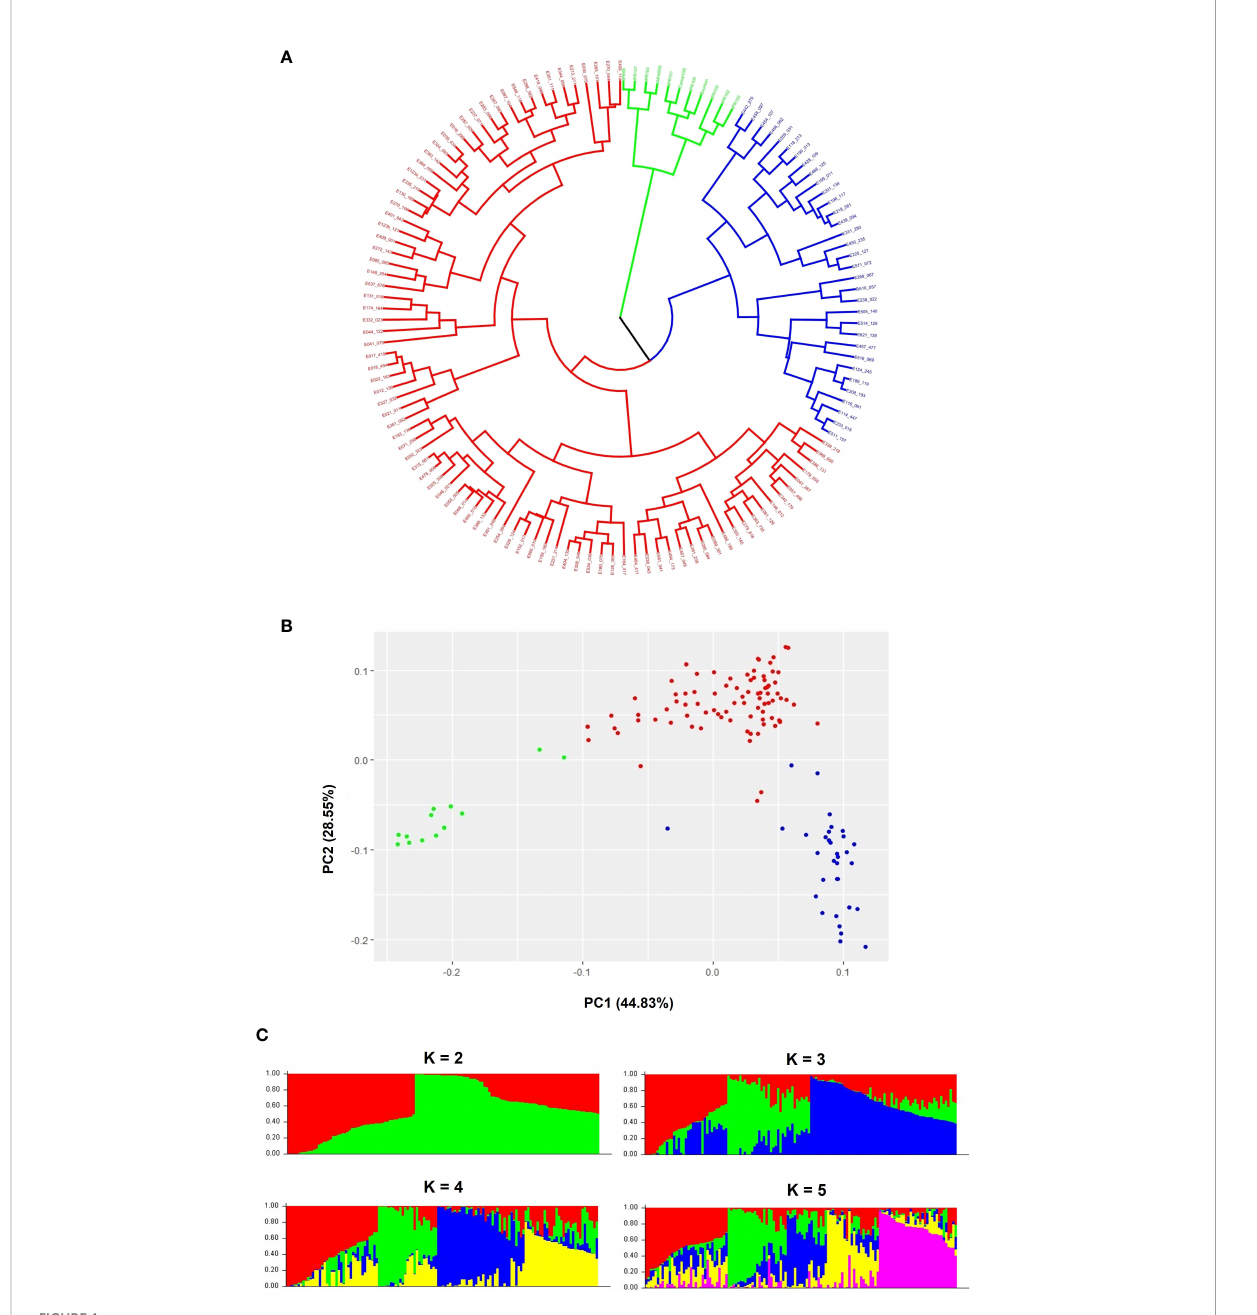
FIGURE 1 Genetic population analysis among 132 Coffea arabica genotypes using 11,290 SNPs. (A) Dendrogram; (B) principal coordinate analysis (PCA). Each point represents an accession, n = 132. In the PCA the accessions were colored according to the cluster: red “ domesticated ” , blue “ wild ” , and green “ cultivar ” . (C) Bar plots of the estimated membership coef fi cient of the 132 C . arabica accessions for K = 2, K = 3, K = 4 and, K = 5, using